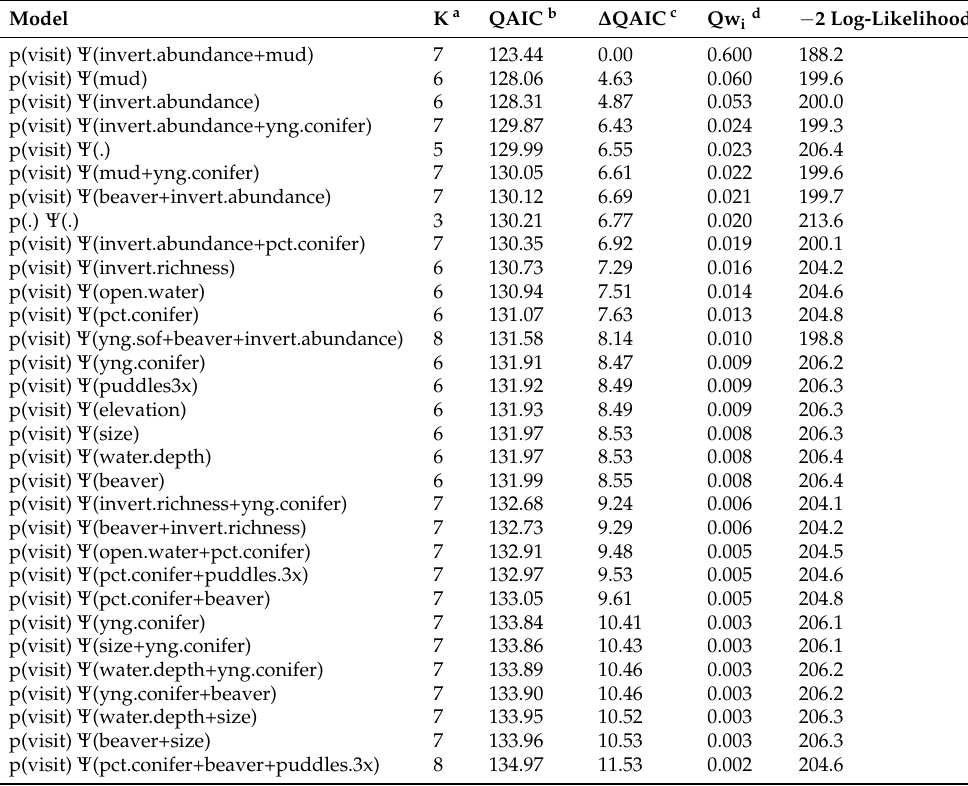
Table 3. Model selection for wetland use of Rusty Blackbirds in northern New England in 2014, using site occupancy analysis with AIC scores adjusted for overdispersion (c-hat = 1.78).